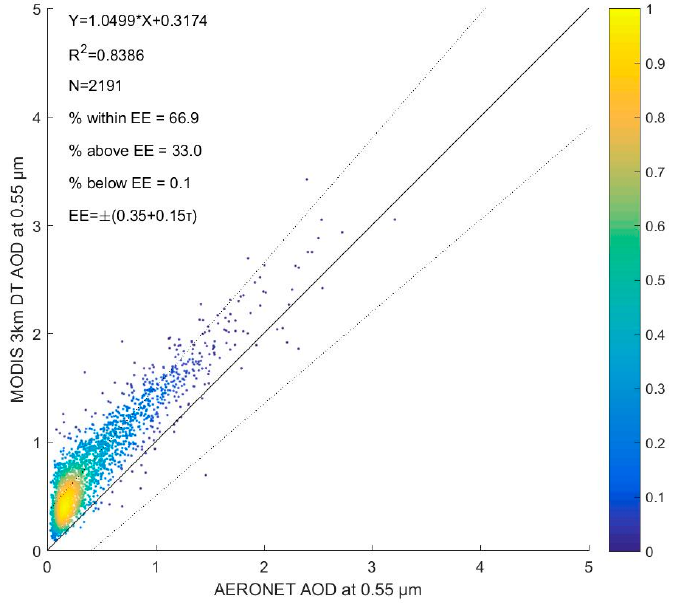
Figure 4. Validation of the MODIS (both Terra and Aqua) 3 km Dark Target AOD against AERONET measurements at the Beijing station, and Beijing-CAMS station.